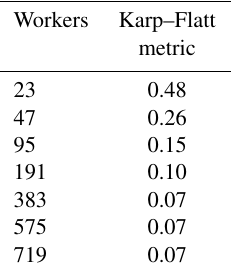
Table 4. Karp–Flatt metric with activated DHT and work package size 16.